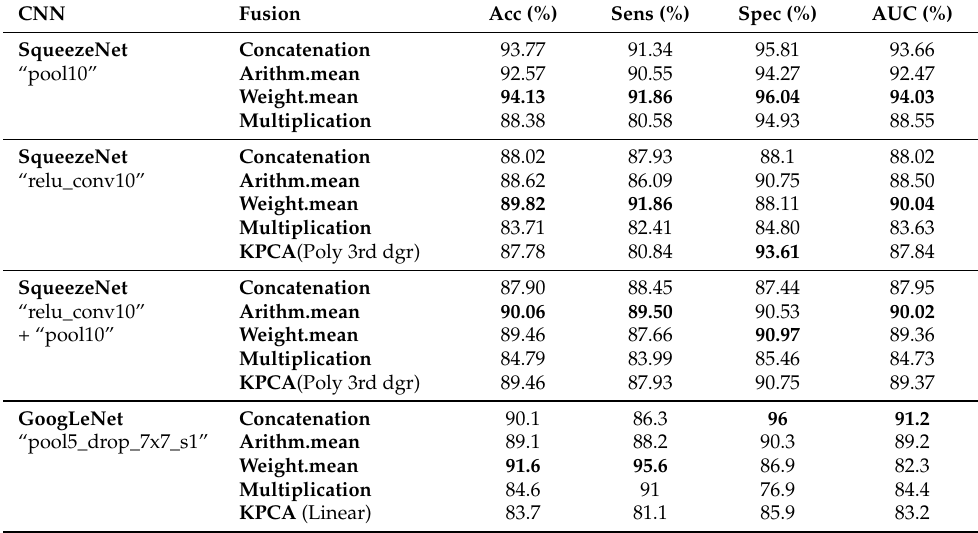
Table 4. The values of the classification performance parameters for CNNs when performing classifier level